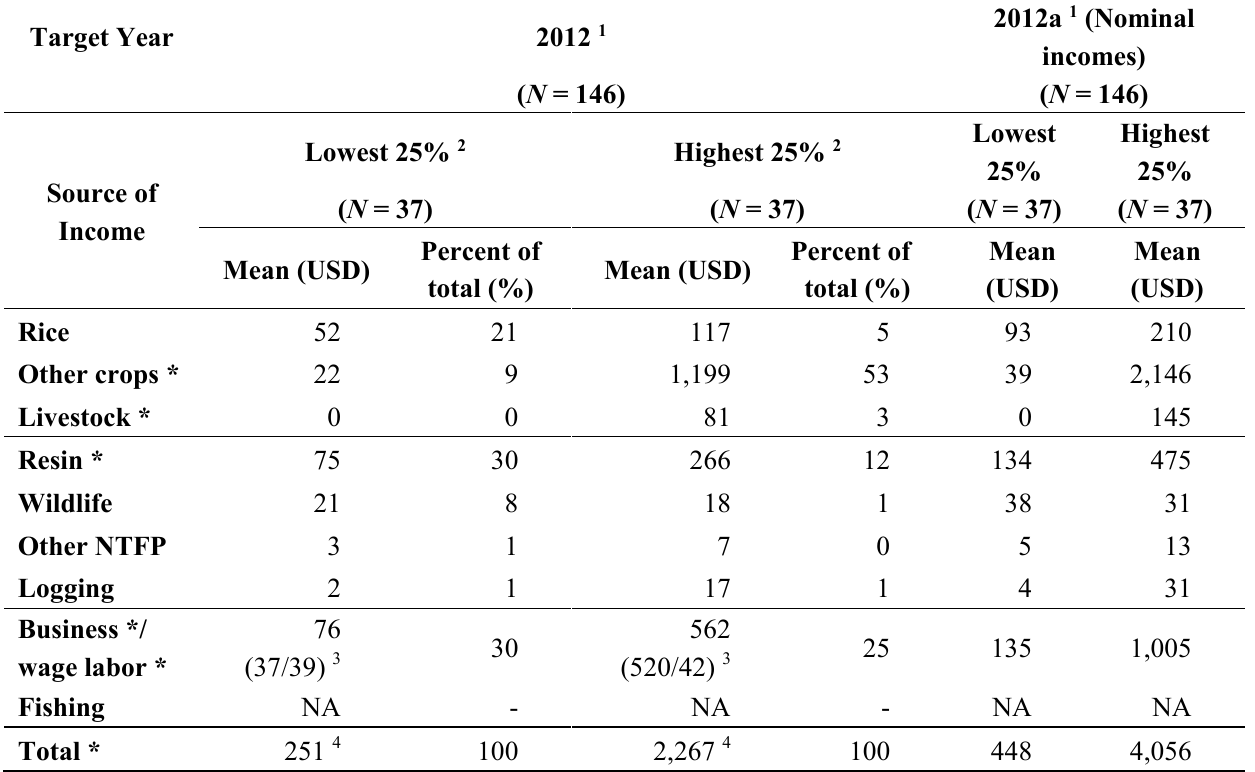
Table 4. Average total HH incomes and income sources in 2012 for the lowest and highest 25% of